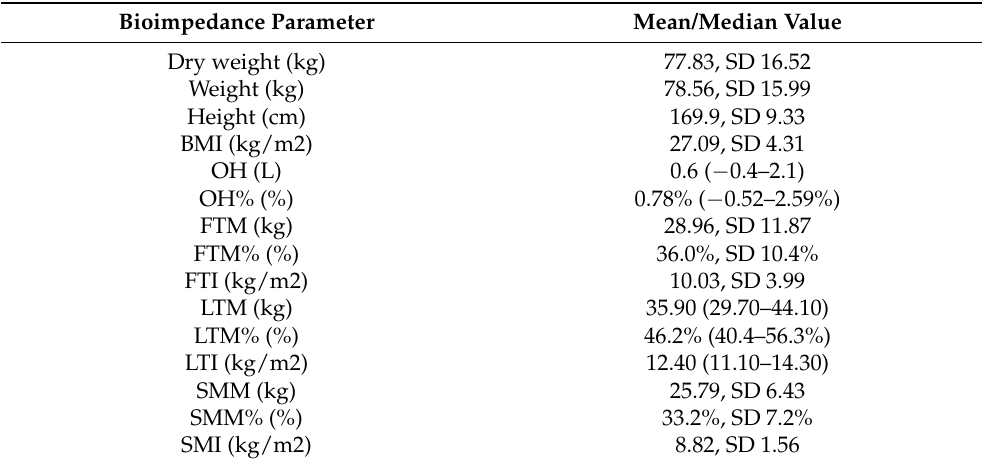
Table 6. Body composition parameters.